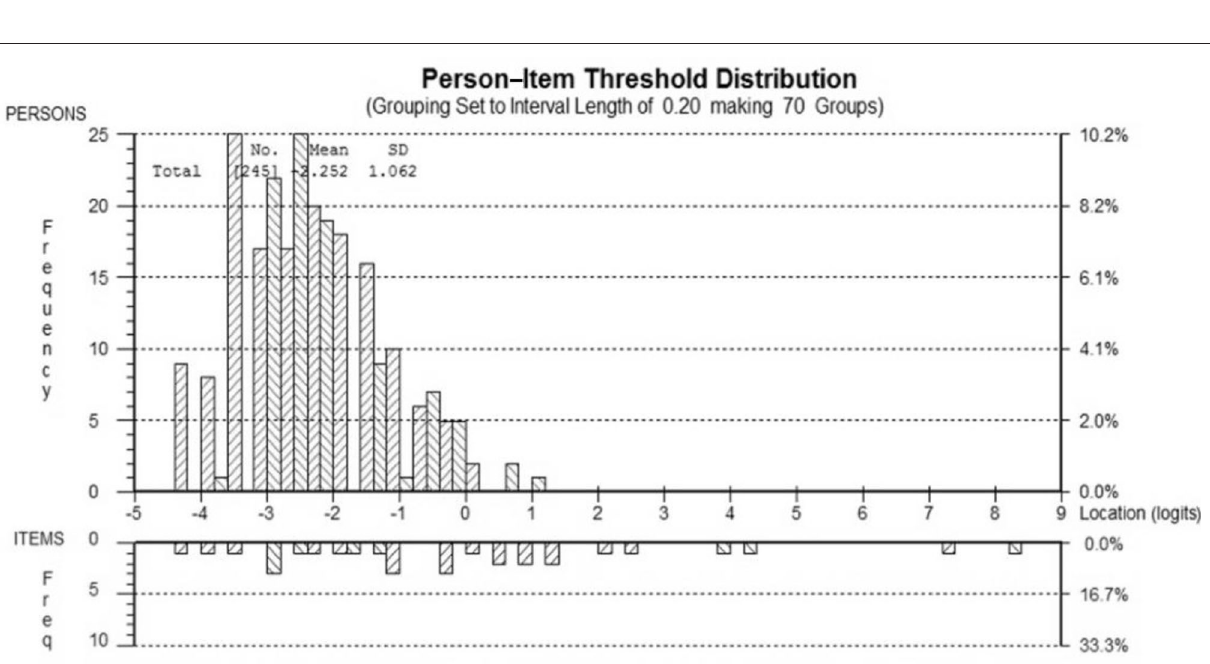
Frontiers in Neurology | www.frontiersin.org